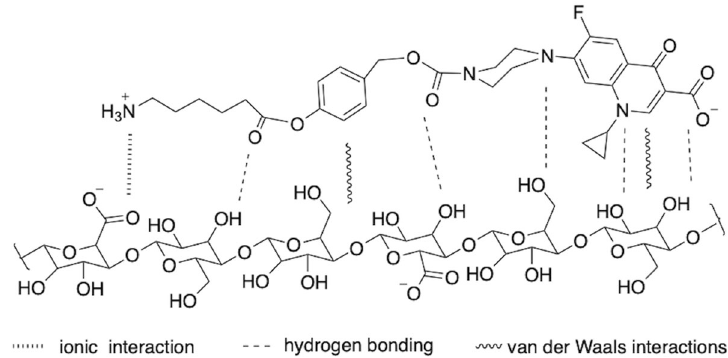
Fig. 8 Adsorption of the cipro fl oxacin-prodrug onto CNF-t. Possible stabilizing effects include ionic interaction, hydrogen bonding, and van der Waals